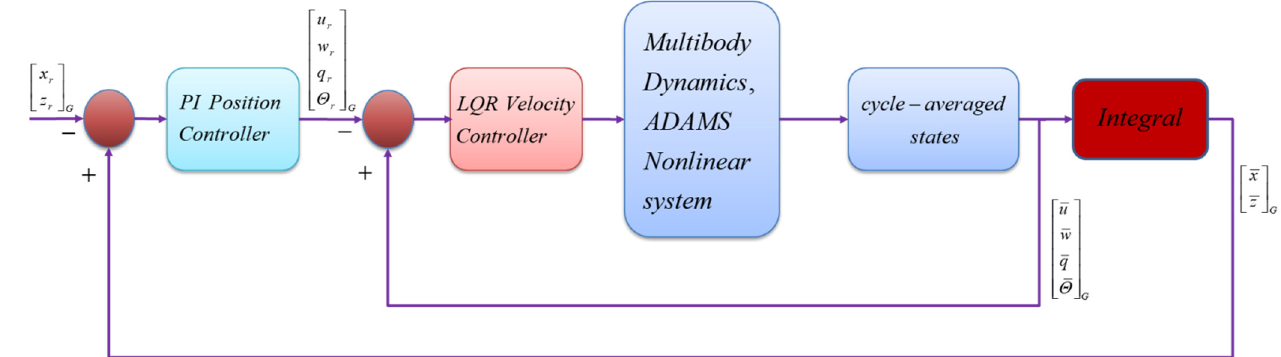
Figure 12. Schematic diagram of dual loop position control for reference trajectories tracking for the nonlinear multibody model.